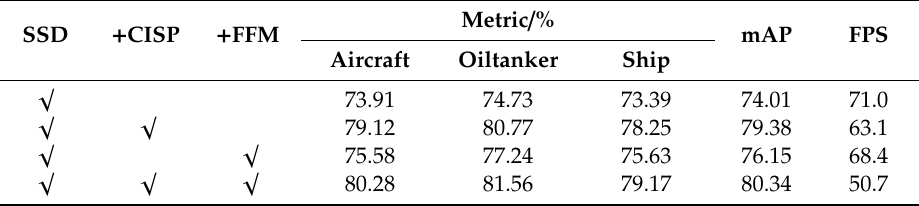
Table 3. Ablation study of CISPNet on the remote sensing image dataset